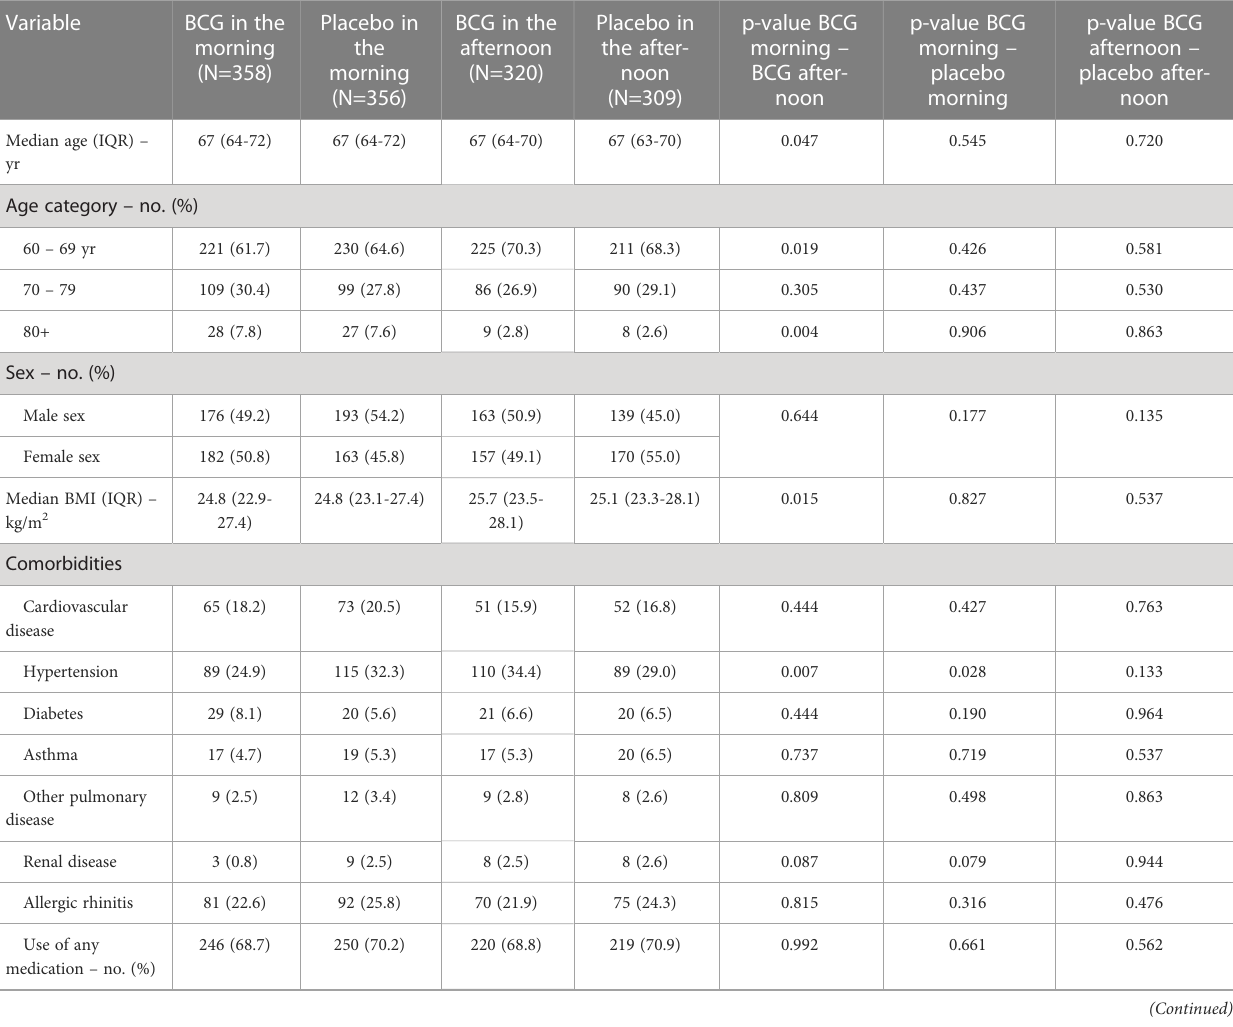
TABLE 1 Baseline characteristics of study